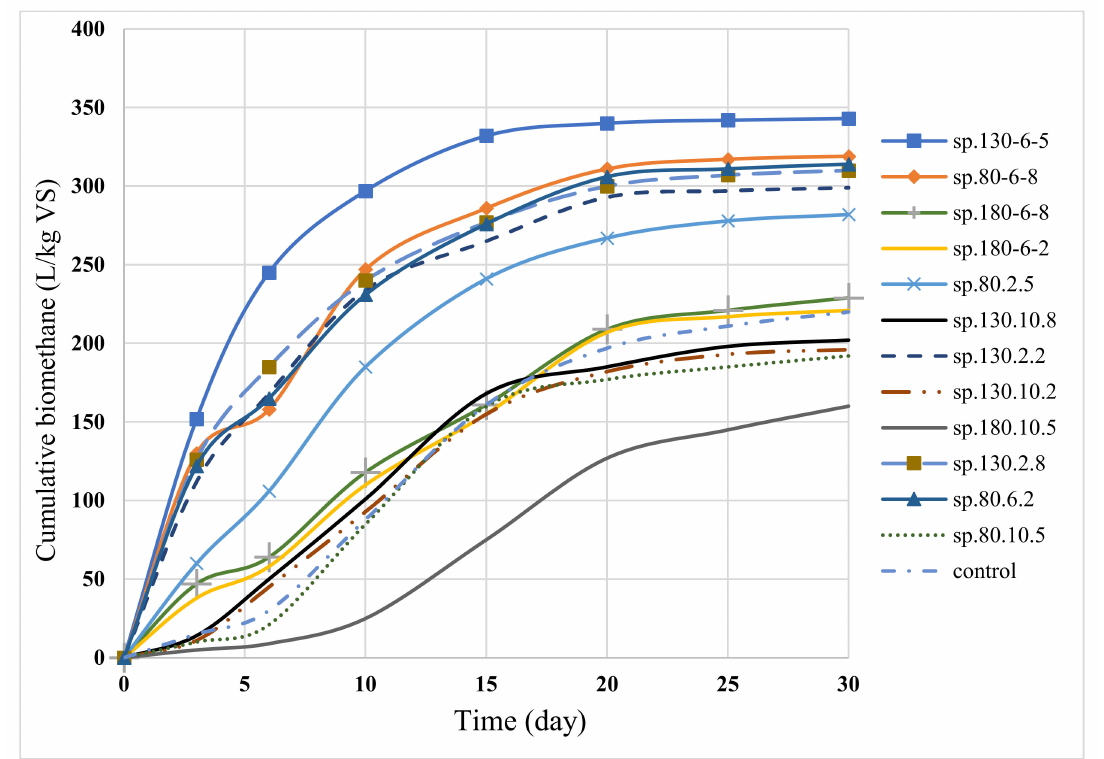
Figure 4. Cumulative biomethane generated during anaerobic digestion of OFMSW.